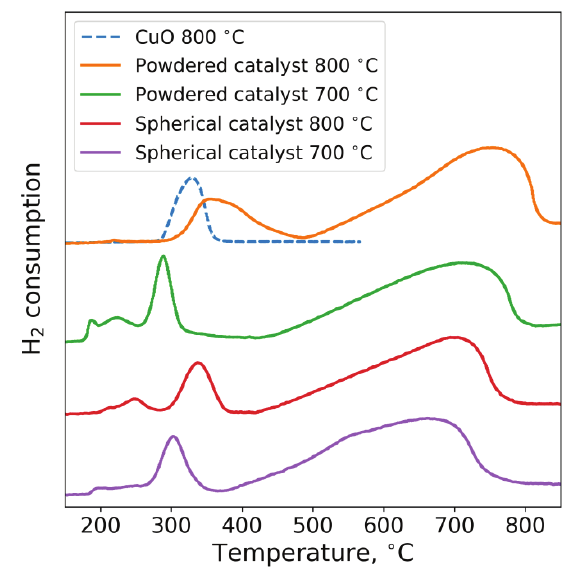
Figure 6. TPR-H 2 profiles of CuFeAl nanocomposite catalysts.